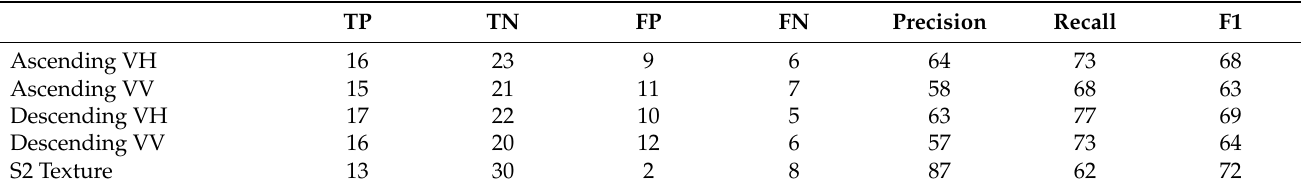
Table 2. The results of precision, recall, and F1 for the chosen thresholds in the